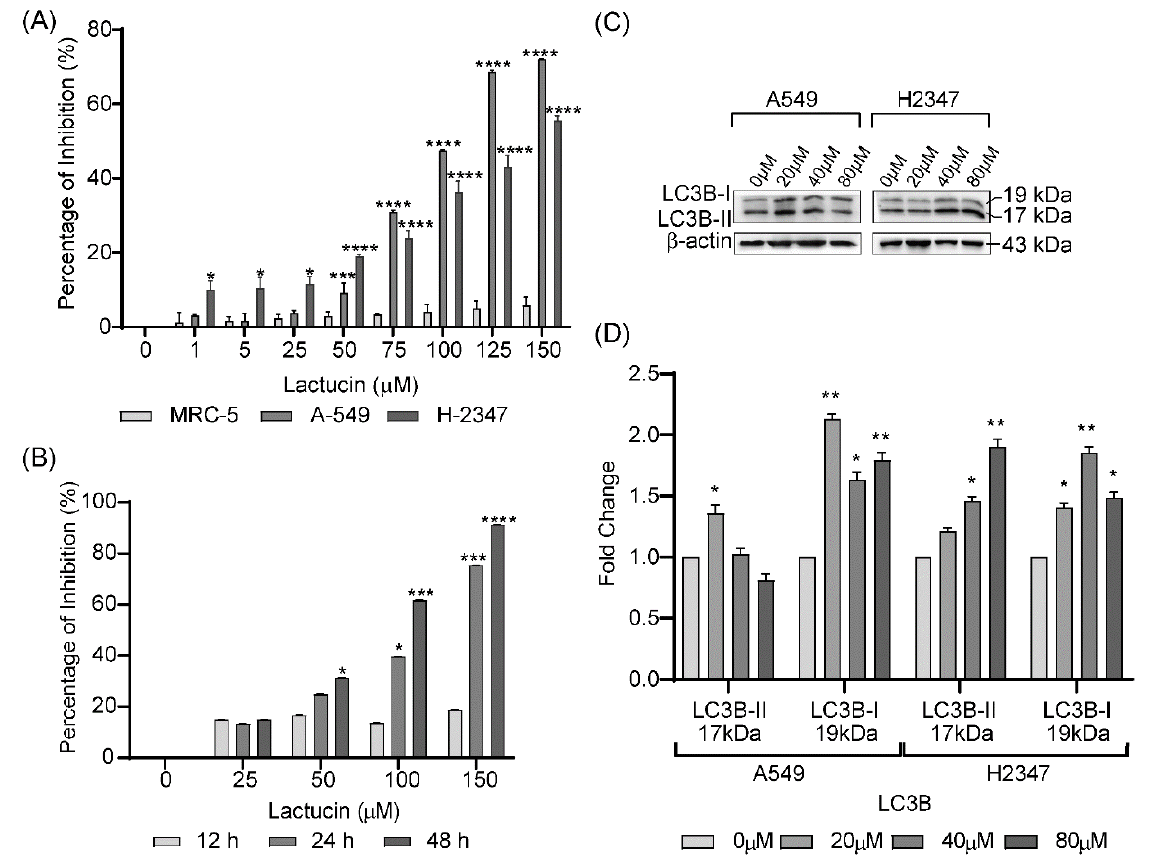
Figure 1. Lactucin significantly inhibits the proliferation of A549 and H2347 lung adenocarcinoma, while it doesn’t inhibit MRC-5 normal lung cell growth in a dose ( A ) and time ( B ) dependent manner. Lactucin significantly induces dose-dependent expression of LC3-II in H2347 cells ( C , D ), detected by WB analysis. Here * p < 0.05, ** p < 0.01, *** p < 0.001, and **** p < 0.0001 indicate significantly different from control.